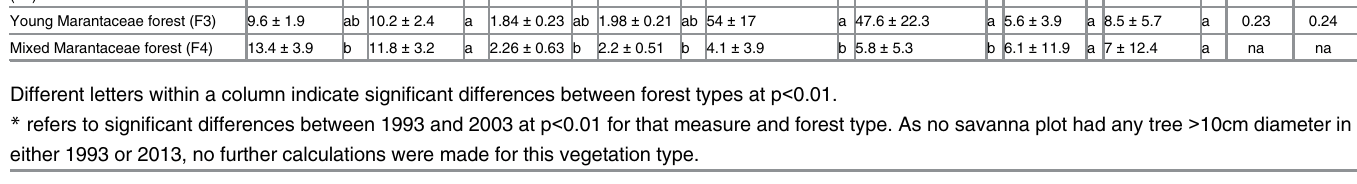
2000 and 2013. The discrepancy is likely due to dry-season cloudiness meaning that data was missing for most of the fire-prone months each year, thus the use of MODIS products to infer fire impacts for this region is not further recommended.